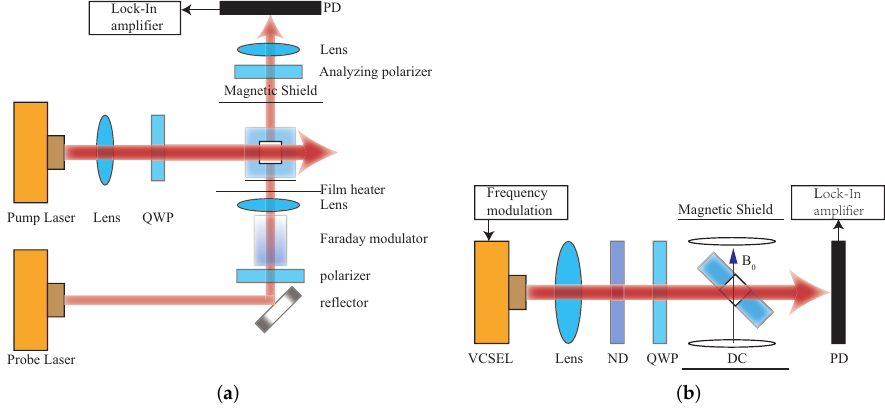
Figure 2. ( a ) Structure of SERF magnetometer; ( b ) structure of the Bell–Bloom type SERF magnetometer.